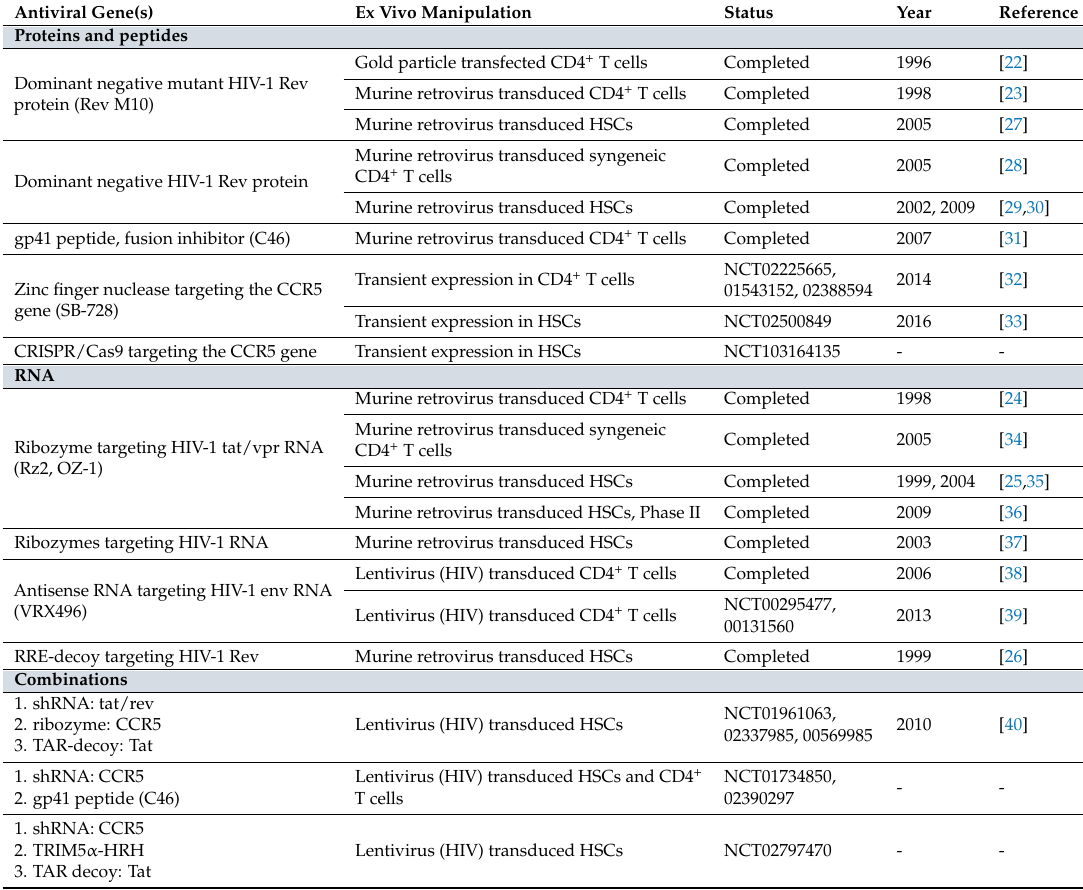
Table 1. HIV-1 resistant cell transplant clinical